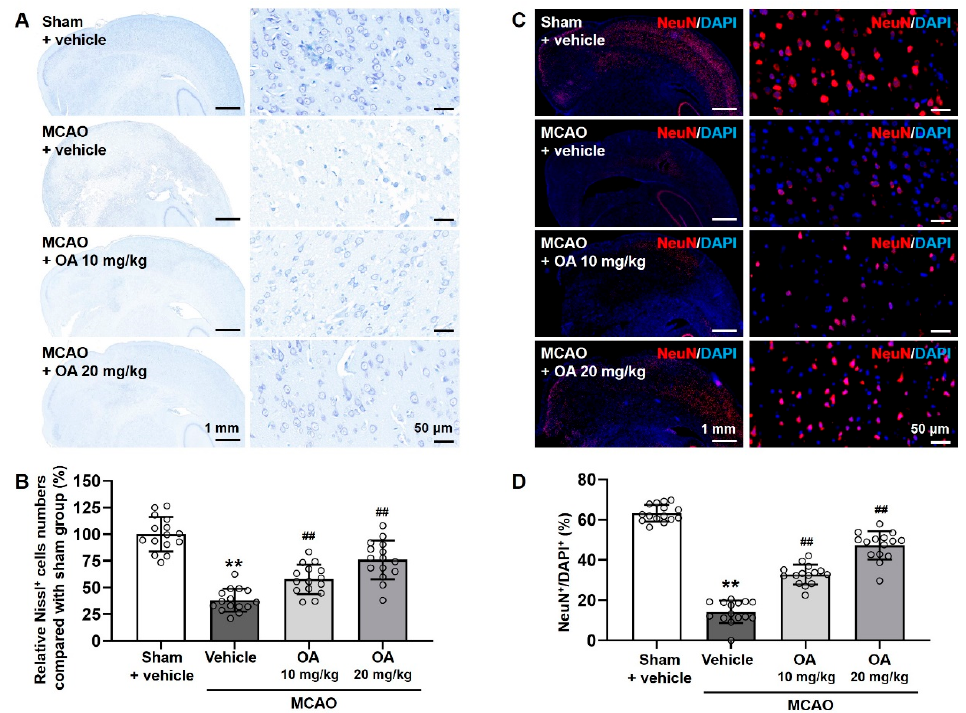
Figure 3. OA administration reduced neuronal damage in MCAO rats. ( A ) Representative images of Nissl staining and ( B ) quantitative analysis of the proportion of Nissl + cells in the infarcted area in MCAO rats with or without OA administration. ( C ) Representative images of NeuN immunofluorescent staining and ( D ) quantitative analysis of the proportion of NeuN + cells in the infarcted area in MCAO rats with or without OA administration. Data are shown as the mean ± S.D. Scale bars: 1 mm and 50 μm . ** p < 0.01 versus the sham + vehicle group; ## p < 0.01 versus the MCAO + vehicle group.